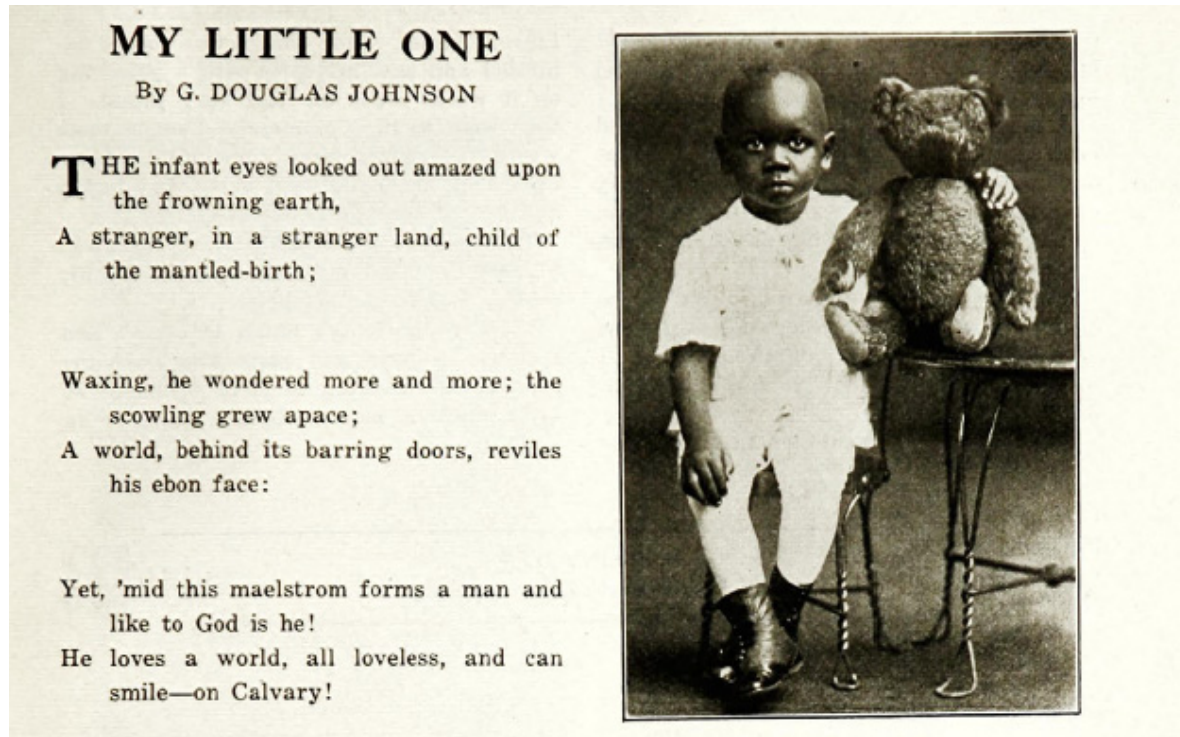
Figure 10. Johnson’s “My Little One” from the 1916 Children’s Number beside a photograph of a child with a teddy bear, a photo most likely submitted by the child’s mother. The Crisis 12.6, p. 273, The Modernist Journals Project, https://modjourn.org/issue/bdr510140/, (accessed on 4 December 2018).